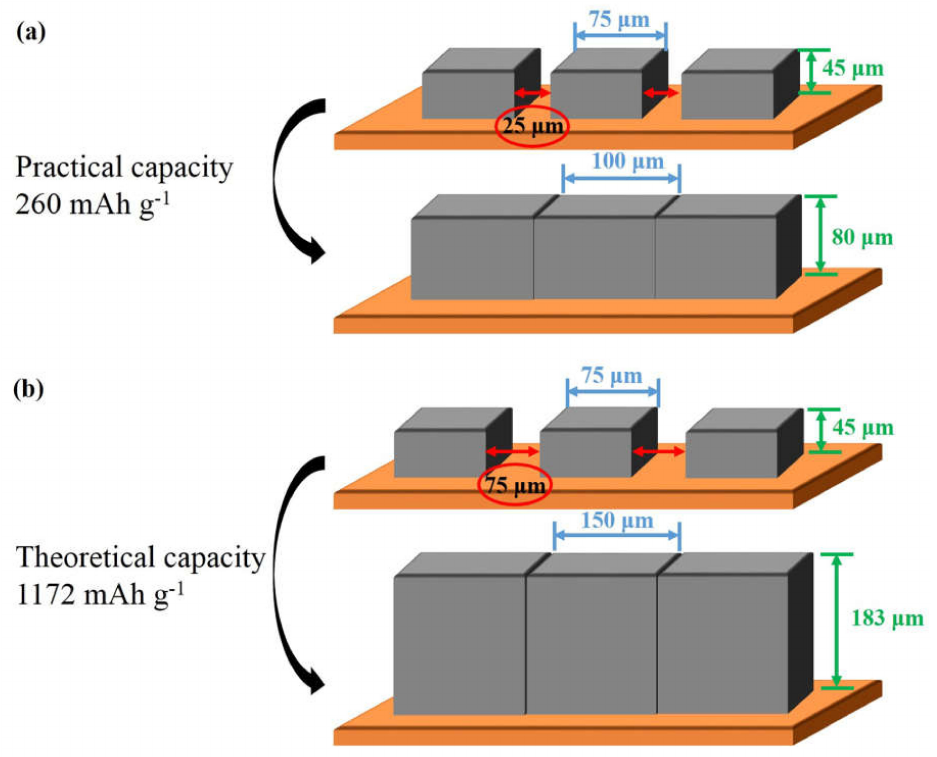
Figure 5. Schematic illustrations of morphology variation in ( a ) the initial structure and ( b ) the optimized structure Si/C composites before and after lithiation.